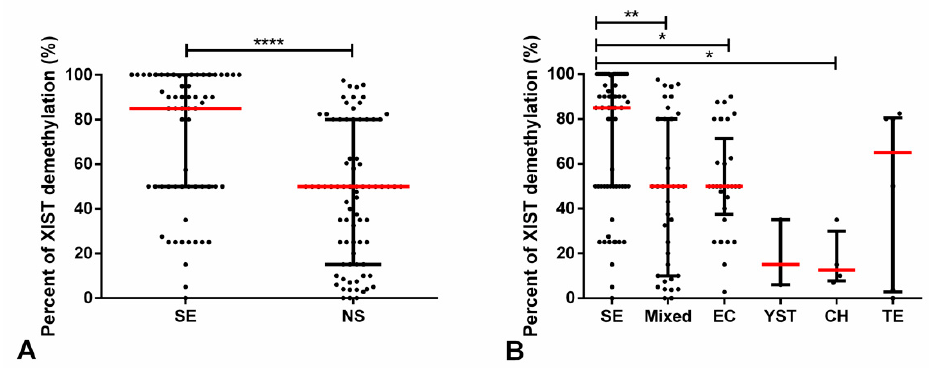
Figure 5. Demethylated XIST fragment percentage among various tumor subtypes (validation cohort). ( A ) Percentage of demethylated XIST fragment in seminoma and non-seminoma and ( B ) percentage of demethylated XIST fragment among all histological subtypes. **** indicates p < 0.0001, *** indicates p < 0.001, ** indicates p < 0.01, and * indicates p < 0.05. Abbreviations: CH—choriocarcinoma; EC—embryonal carcinoma; NS—non-seminoma; SE—seminoma; TE—postpubertal-type teratoma;